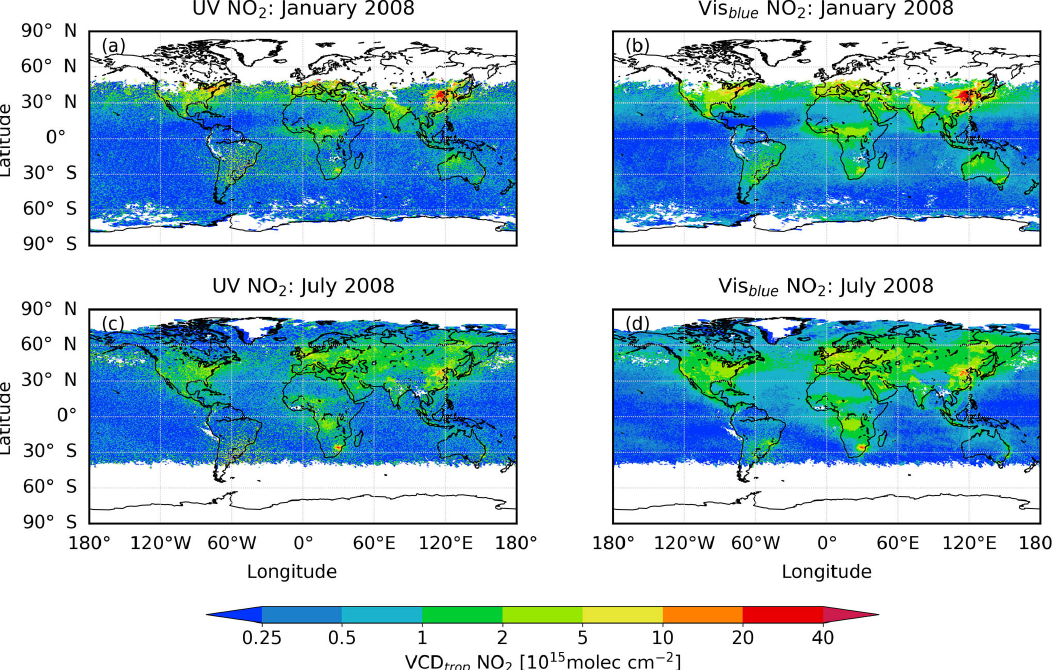
Figure 13. Monthly mean tropospheric NO 2 VCDs for (a, b) January and (c, d) July 2008. (a, c) UV spectral range and (b, d) blue spectral